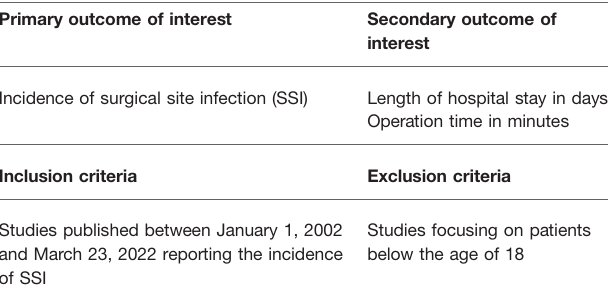
TABLE 2 | Table of primary and secondary outcomes of interest and inclusion and exclusion criteria.